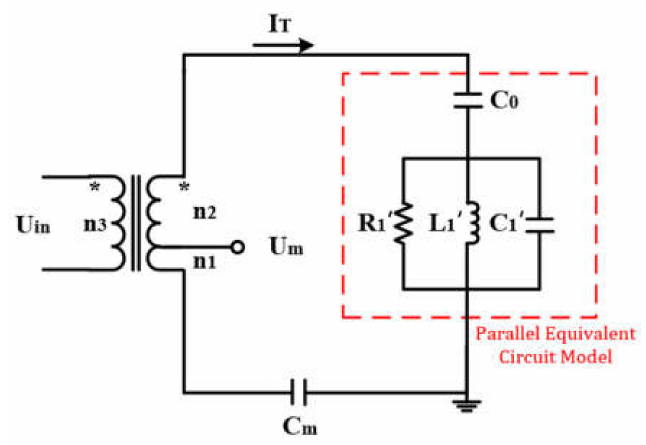
Figure 2. PZT ceramic parallel equivalent circuit and